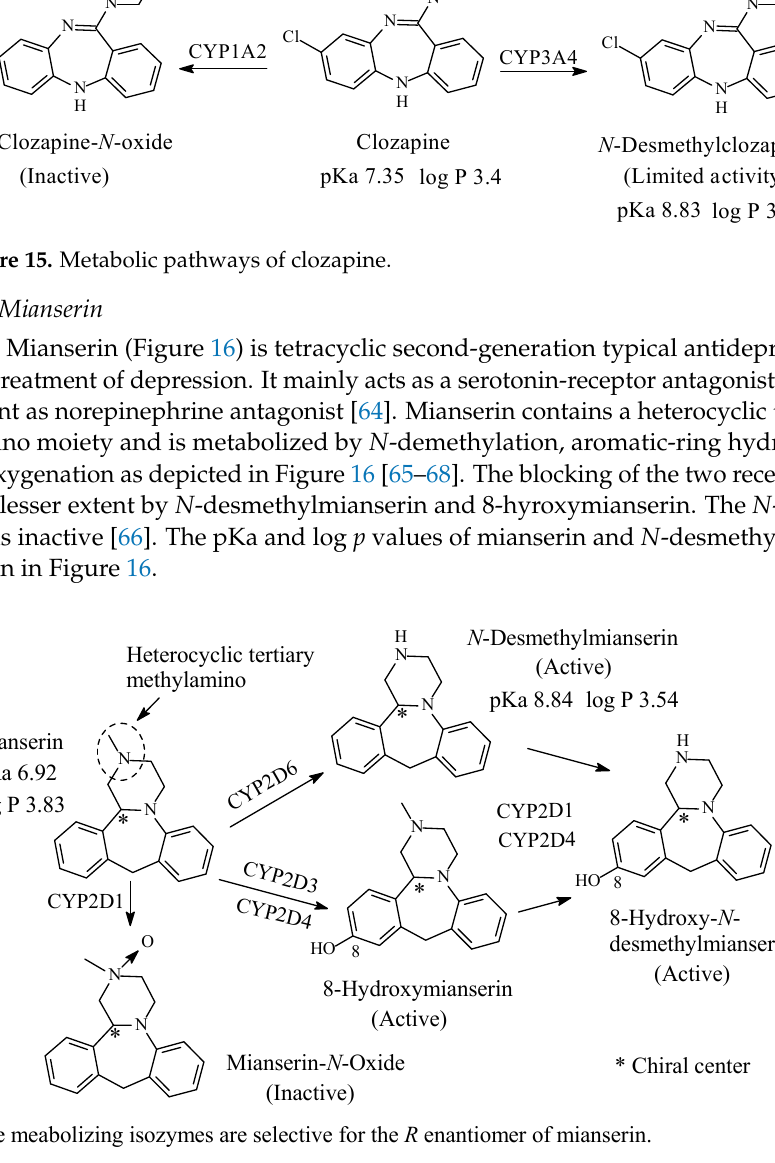
Figure 16. Metabolic pathways of mianserin.